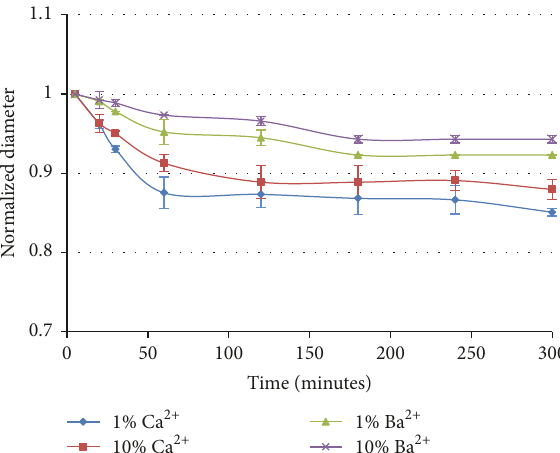
Figure 3: Normalized diameters of alginate beads incubated in different concentrations of Ca 2+ and Ba 2+ at room temperature (25 ∘ C) for various gelling times.